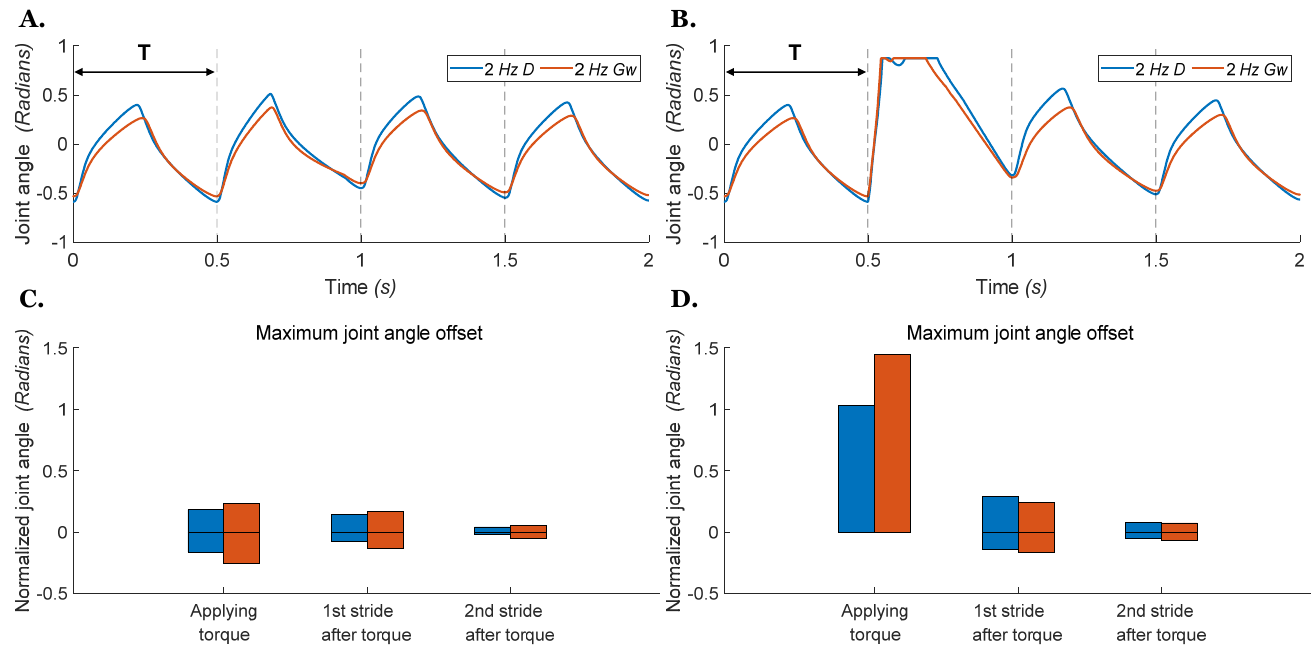
Figure 10. Hip joint angle vs. time during stepping with an external torque applied to the joint during ground walking. The blue 2 Hz D line indicates that the CPG is operating at 2 Hz and driven by the direct stimulus D . The red 2 Hz G w line indicates that the CPG is operating at 2 Hz by neuromodulation of the weak excitatory synapse conductivity G w . The torque is applied on the left femur at the start of the second stance phase with a duration of one step cycle. Dashed lines indicate when the transition from extension to flexion would occur if there was no perturbation. ( A ) Small torque perturbation ( − 0.02 Nm) as in Figure 9A. ( B ) Large torque perturbation ( − 0.1 Nm) as in Figure 9B. ( C ) Bars present the range of joint offset from the nominal profile during and after applying a small external torque as in ( A ). ( D ) Bars present the range of joint offset from the nominal profile during and after applying a large external torque as in ( B